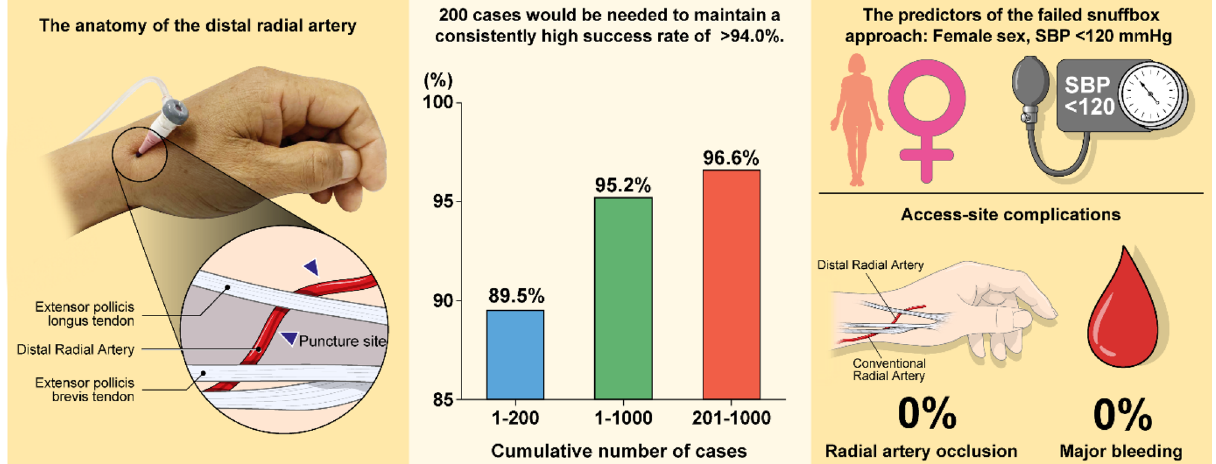
Figure 4. Summary of study regarding the learning curve of the distal radial access (DRA) for coronary intervention. (Left panel) Distal radial artery puncture site in the anatomical snuffbox located between tendons of the extensor pollicis longus and the extensor pollis brevis. (Central panel) Success rate of DRA showing 95.2% in a total of 1000 study population, 89.5% in 1–200 patients, and 96.6% in 201–1000 patients. (Right panel) Predictors of the failed DRA and access-site